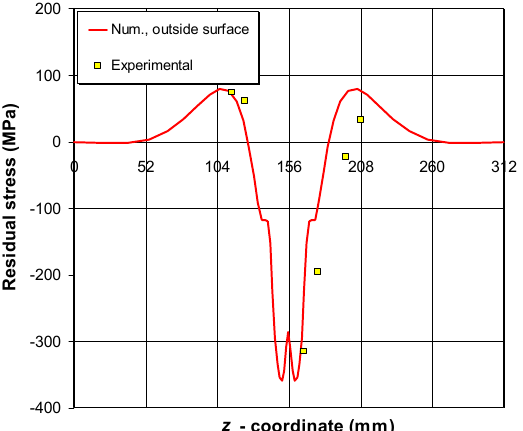
Figure 10. Peak process temperature and moving the electrode.